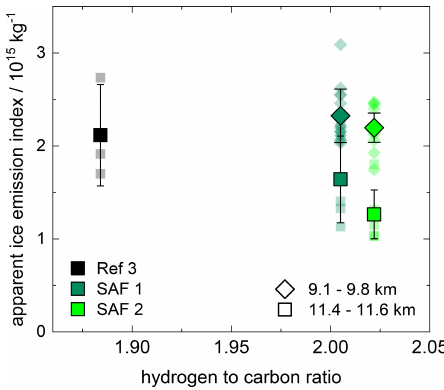
Figure 2. AEI with respect to the hydrogen-to-carbon (H : C) ratio of the fuels at two different flight altitudes. H : C ratio of Ref 3 (black): 1.884; SAF 1 (dark green): 2.005; SAF 2 (light green): 2.022. Small symbols show the upper 15% of the single-plume encounters. Error bars show the standard deviations of the single- plume